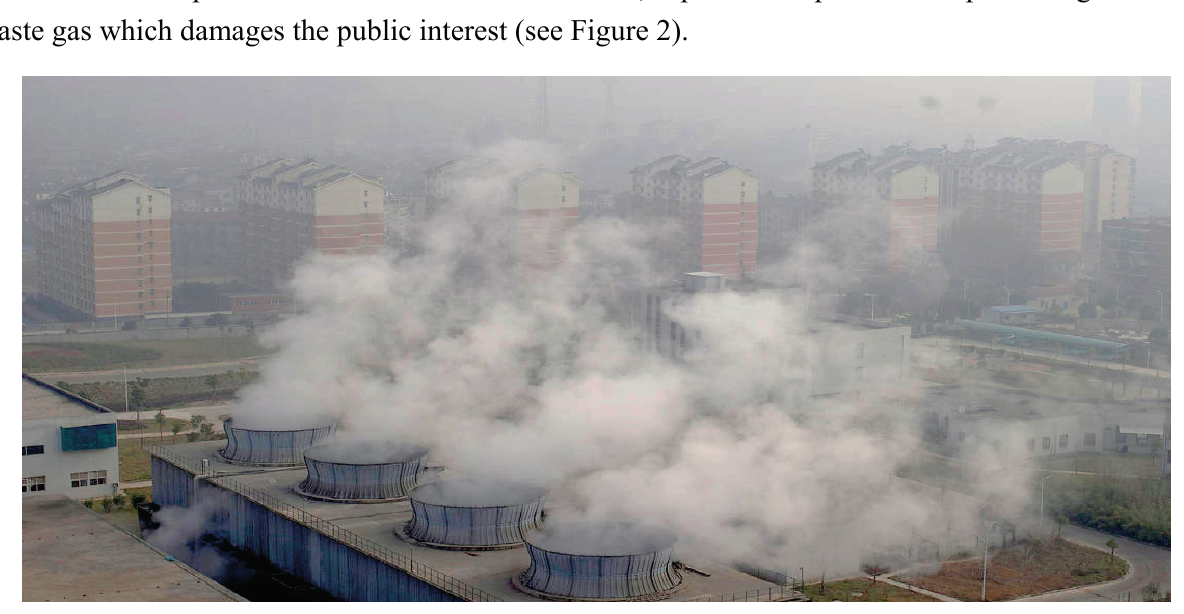
Figure 2. Guodingshan waste incineration plant with residential buildings